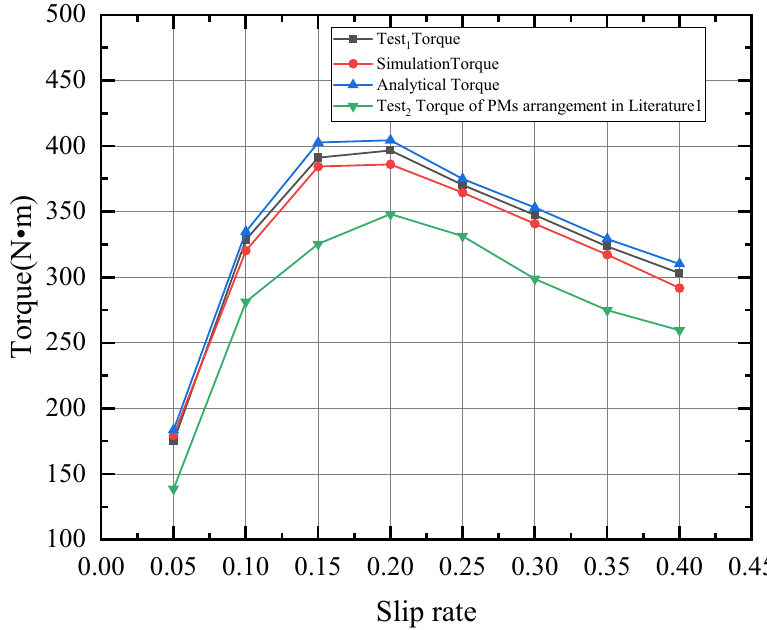
Figure 17. Comparison of average output torque under different slip rates.